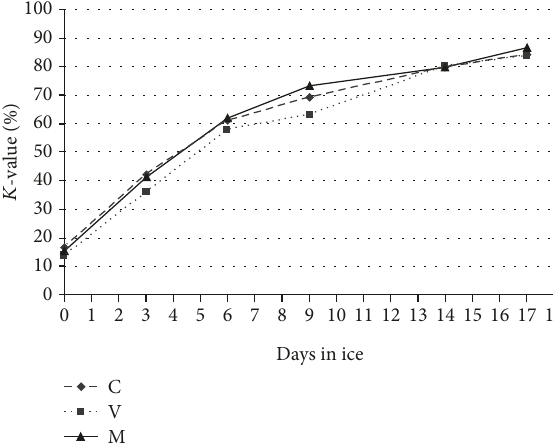
Figure 1: QIM freshness sensory scores for the three rainbow trout dietary groups (C: commercial diet; M: marine diet; V: plant-based diet) stored in ice.